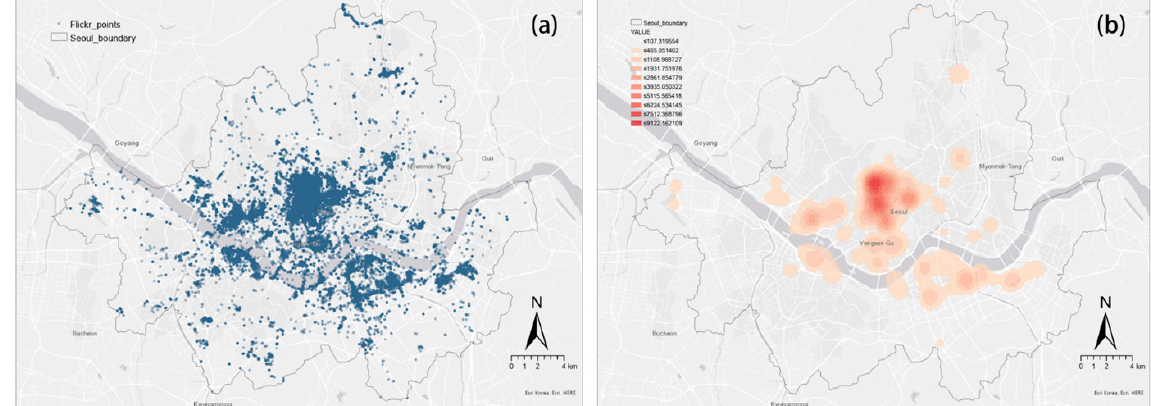
Figure 12. Kernel density map of tourist photos: ( a ) dot map; and ( b ) kernel density map.